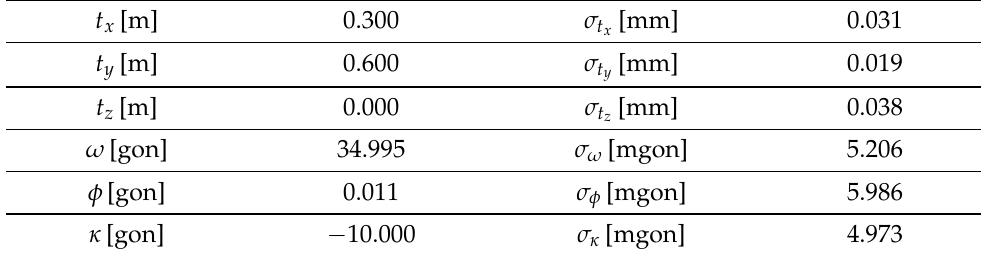
Table A4. Results of the estimated rigid body movement after having extended S CS (data set V18, a = 0, n CS = 23, n CS , ex = 47)